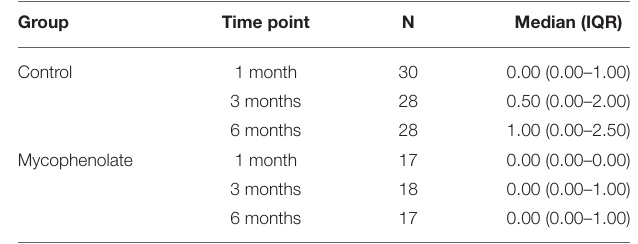
TABLE 7 | Granulation tissue grades summarized as median with interquartile range